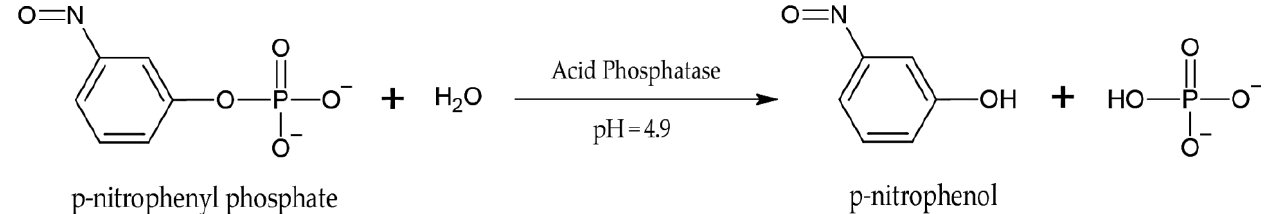
Figure 3. Acid phosphatase catalytic reactions.